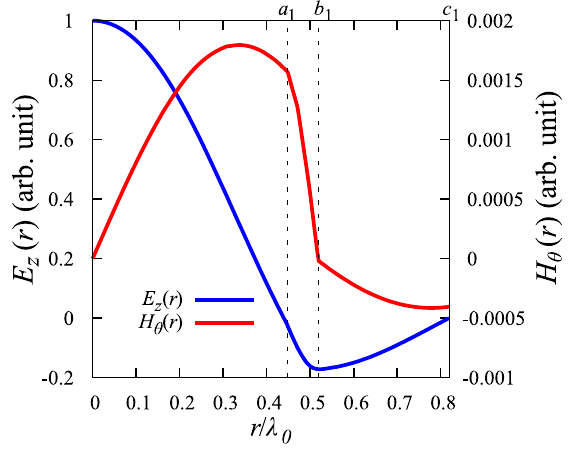
FIG. 5. Normalized longitudinal electric field, E z ð r; z (blue line) and rotating magnetic field, H θ ð r; z of the accelerating mode along the r axis.